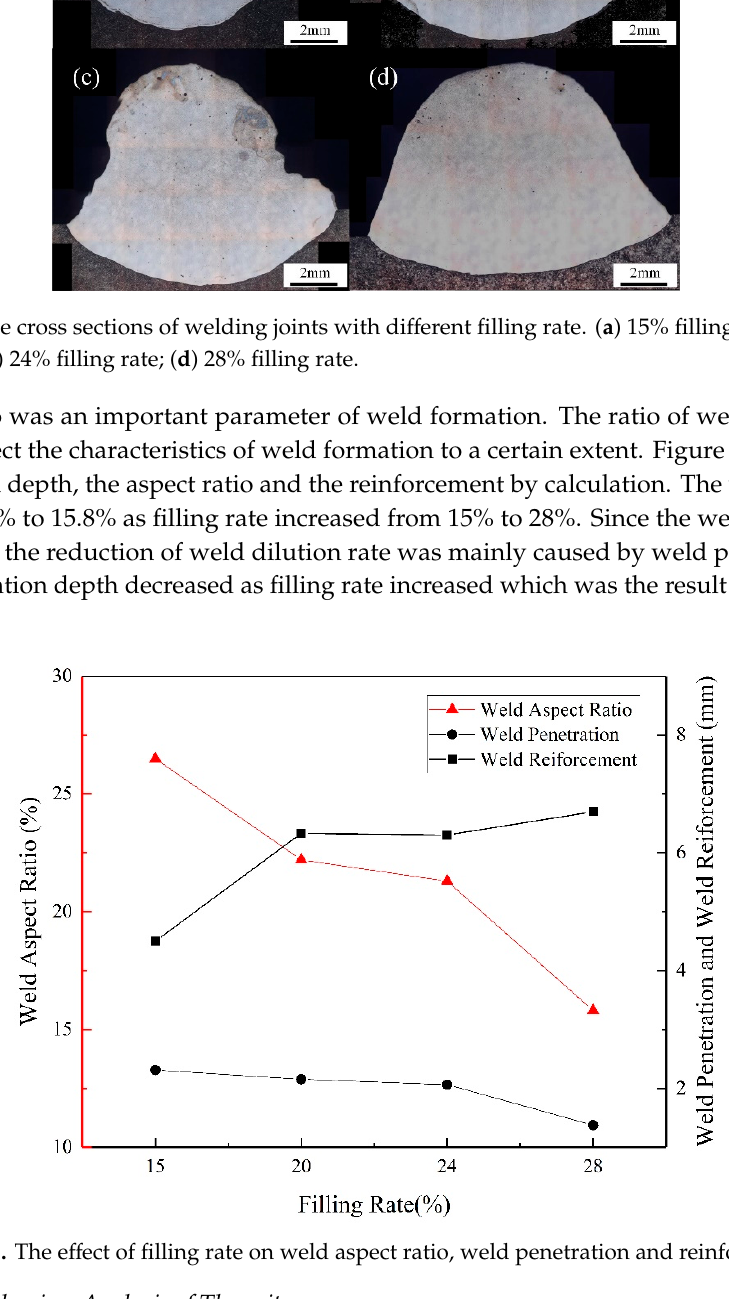
ff ect of filling rate on weld aspect ratio, weld penetration and Figure 13. The effect of filling rate on weld aspect ratio, weld penetration and reinforcement. Figure 13. The e